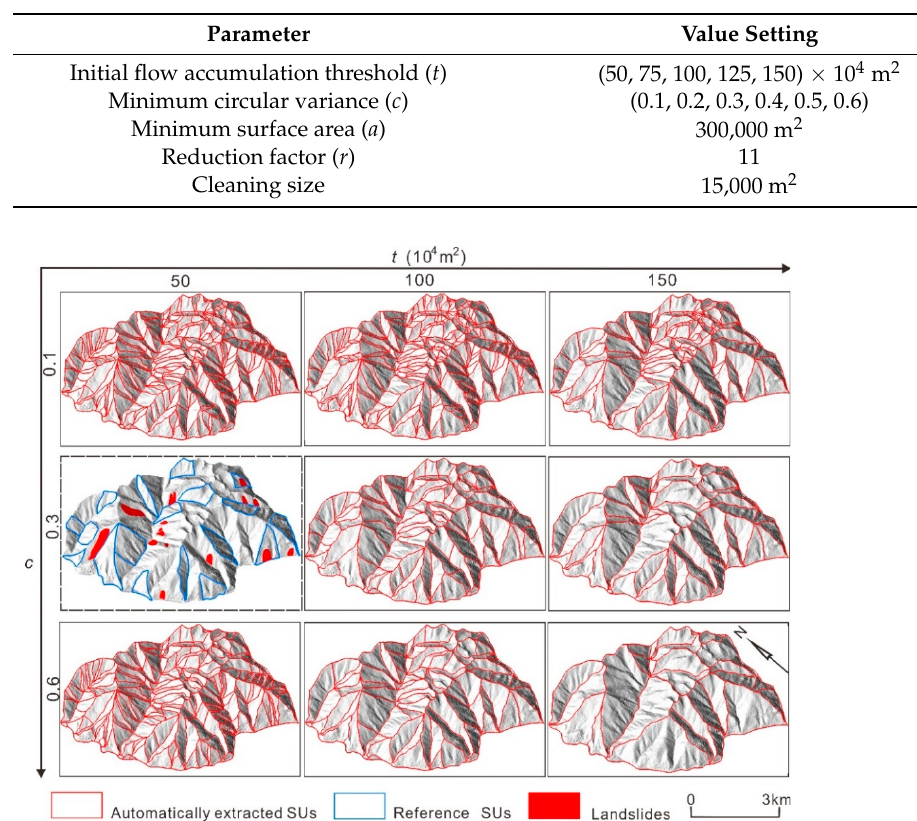
Table 2. Parameters settings for r.slopeunits.